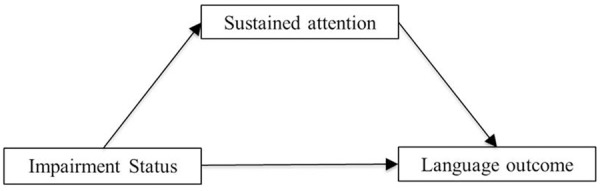
Mediation model.